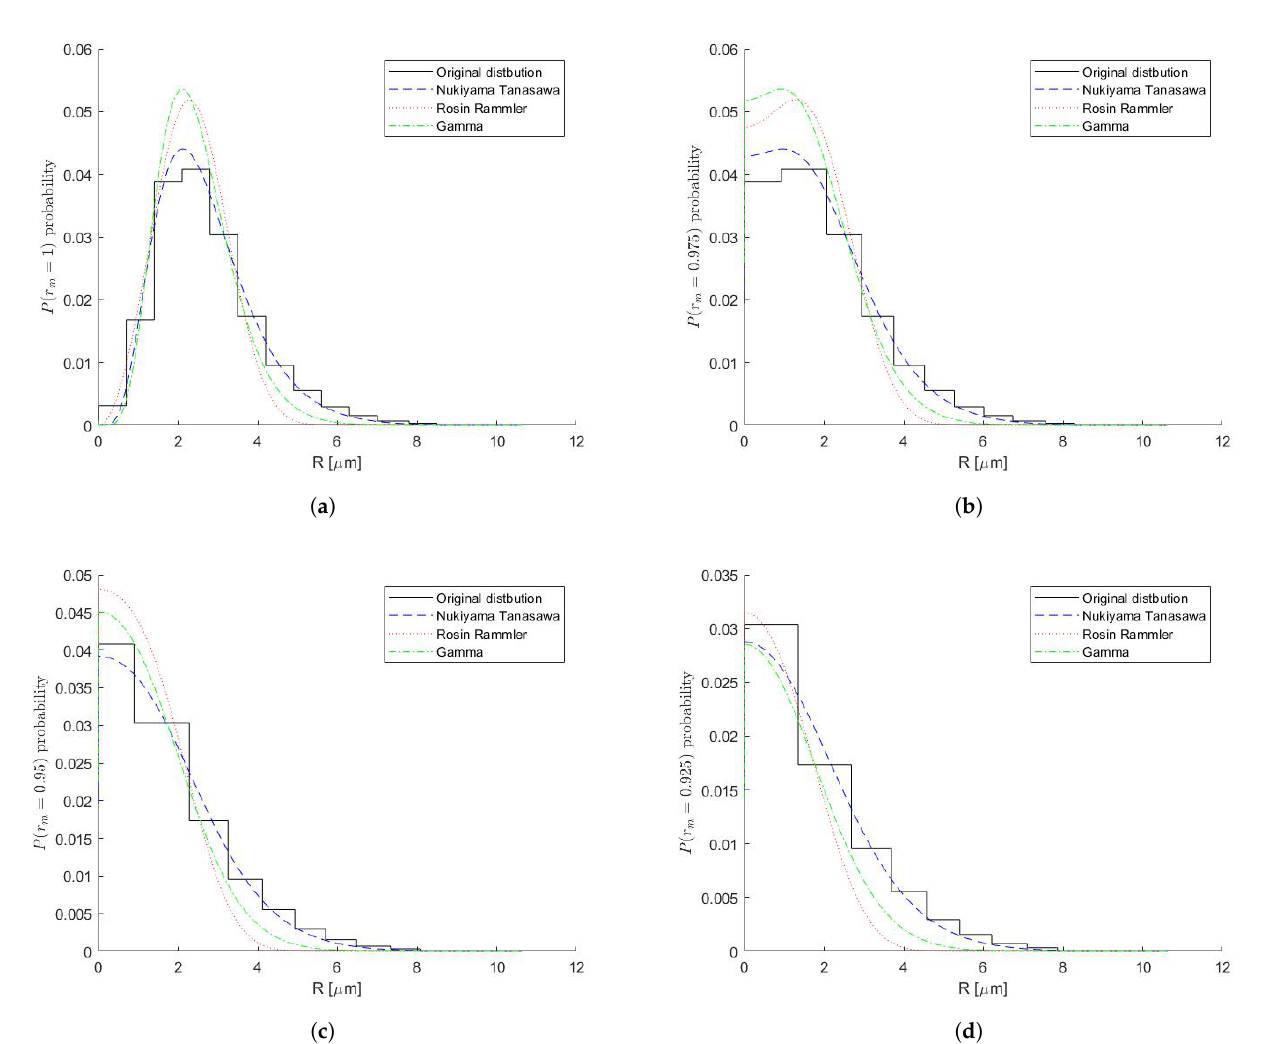
Figure 4. Nukiyama–Tanasawa, Rosin–Rammler, and gamma probability for various r m values. ( a ) Probability at r m = 1. ( b ) Probability at r m = 0.975. ( c ) Probability at r m = 0.95. ( d ) Probability at r m = 0.925.